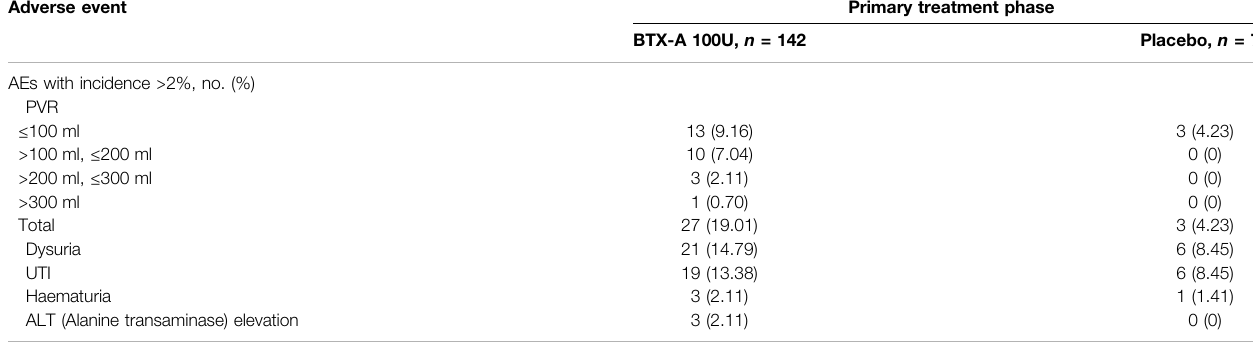
TABLE 3 | Safety parameters in two consecutive treatment phases in the safety population. Adverse event Primary treatment phase BTX-A 100U, n = 142 Placebo, n =